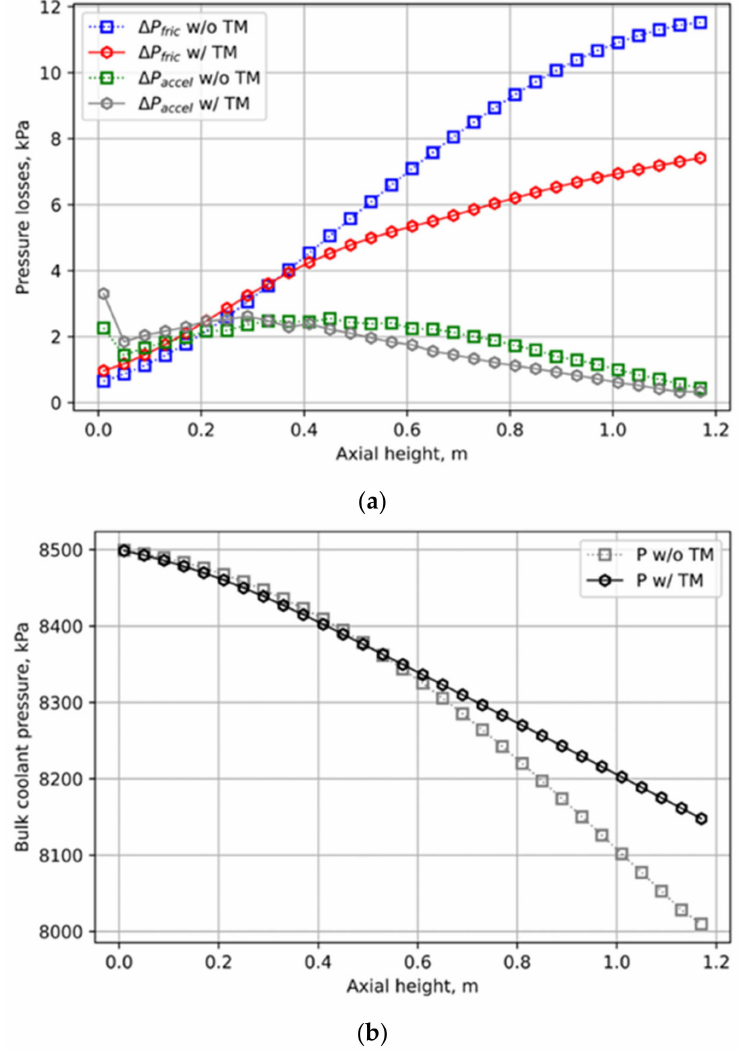
Figure 14. Comparison of hot channel ( a ) pressure losses; ( b ) bulk coolant pressure.